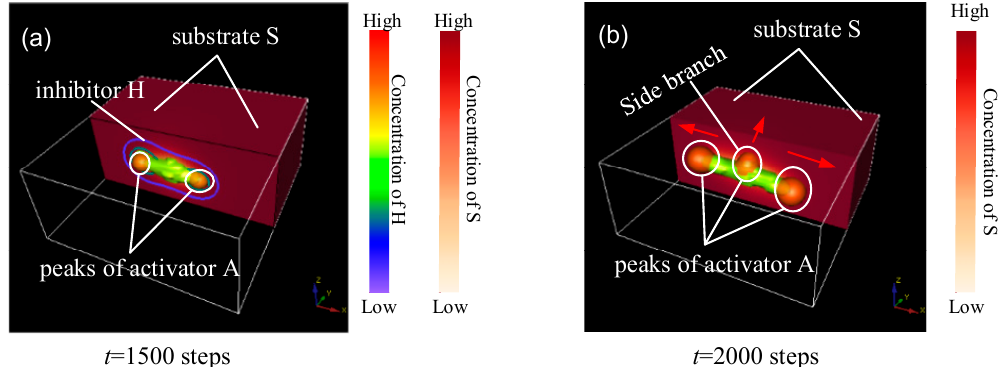
Figure 1 . Concentration distribution of A , H , and S in side branching. ( a ) Simulation result at t = 1500 steps; ( b ) Simulation result at t = 2000 steps. The green part is the spatial distribution of the cellular differentiation marker Y ; the orange spherical structure is the peaks of activator A ; the contour lines indicated the distribution of H ; the red rectangle is the spatial distribution of the substrate S . Substrates are actually distributed in the area formed by the white rectangular border. To clearly show the intrinsic association of A , H , and S concentration profiles, half of the substrate was hidden. The numbers under the images denote the step number in the simulation. Parameters: c = 0.04, µ = 0.3, v = 0.03, ρ A = 0.03, ρ H = 0.0001, c 0 = 0.02, γ = 0.02, ε = 0.042, d = 0.008, e = 0.1, f = 10, D A = 0.1, D H = 0.26, D S = 0.06.